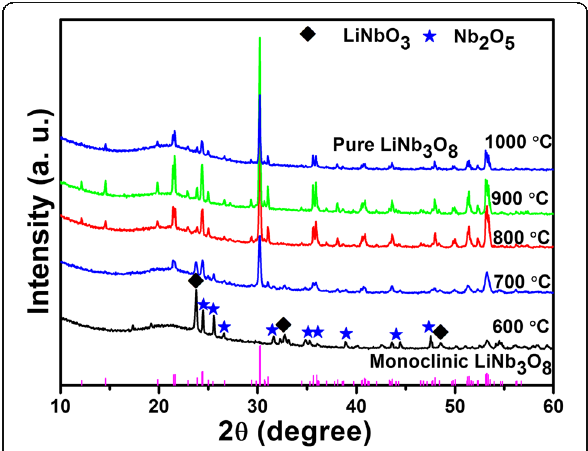
Fig. 1 XRD patterns of the LiNb 3 O 8 powders calcined at different temperatures for 2